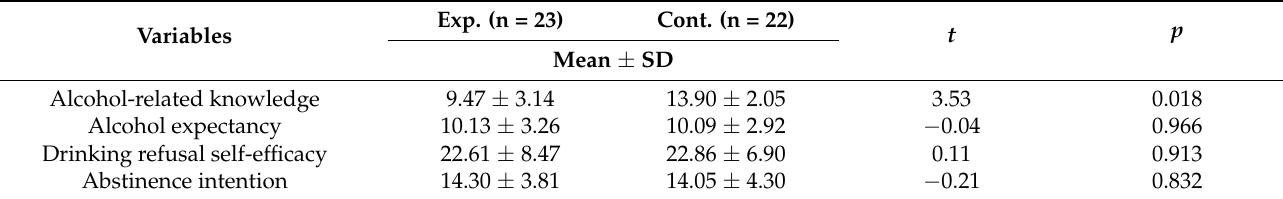
Table 4. Homogeneity of outcome variables ( N = 45).